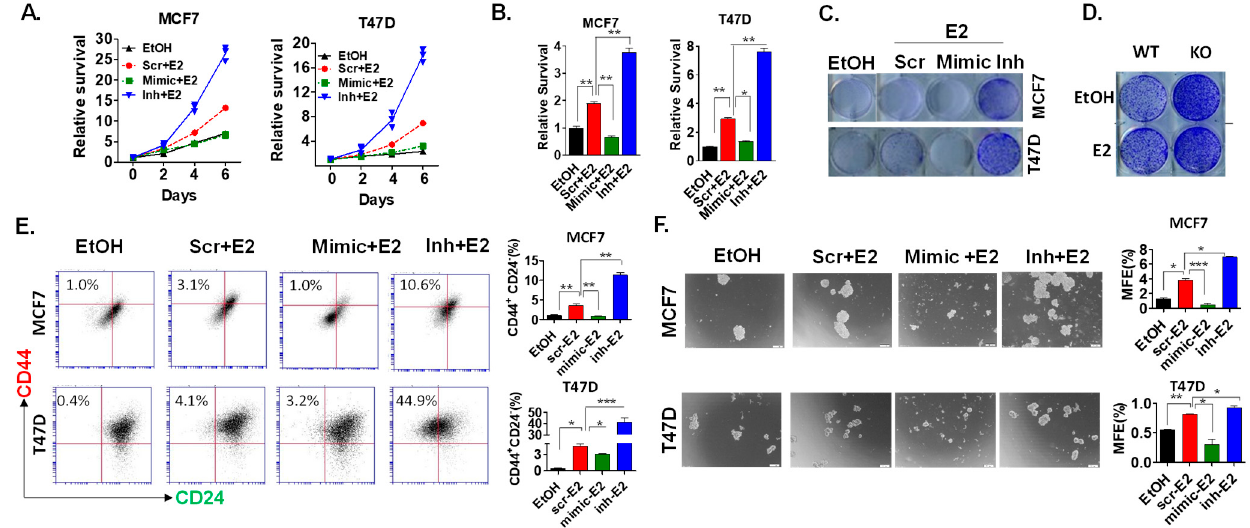
Figure 4. miR-489 acts as an endogenous negative feedback loop to dampen estrogen activities. ( A ) miR-489 restoration inhibited the proliferation of ER+ breast cancer cell lines, while the inhibition of endogenous miR-489 dramatically enhanced the proliferation of MCF7 and T47D. Scramble siRNA, miR-489 mimic, or miR-489 inhibitor were transfected in the presence or absence of estrogen for 72 h, followed by an MTT-based viability assay. ( B ) Quantification of viable cells on day 6 post-treatment of MCF7 and T47D. ( C ) Inhibition of endogenous miR-489 dramatically enhanced estrogen-induced colony formation. MCF7 and T47D cells were transfected with scramble siRNA, miR-489 mimic, and miR-489 inhibitor in the presence or absence of estrogen, followed by a colony formation assay. ( D ) Hormone-starved miR-489 WT and KO T47D cells were seeded in a 12-well plate and treated with ethanol or E2 for 6 days, and cell viability was measured by crystal violet staining. ( E ) Breast cancer cell lines were transfected with scr, mimic, or inhibitor in the presence of estrogen for 72 h, followed by flow cytometry to examine CD24 and CD44 surface markers. ( F ) Breast cell lines were transfected with scr, mimic, or inhibitor in the presence of estrogen for 72 h, followed by a mammosphere assay. Scr = Scramble control; Inh = Inhibitor of miR-489. * p < 0.05; ** p < 0.01; *** p < 0.001. Data are representative of three independent experiments.